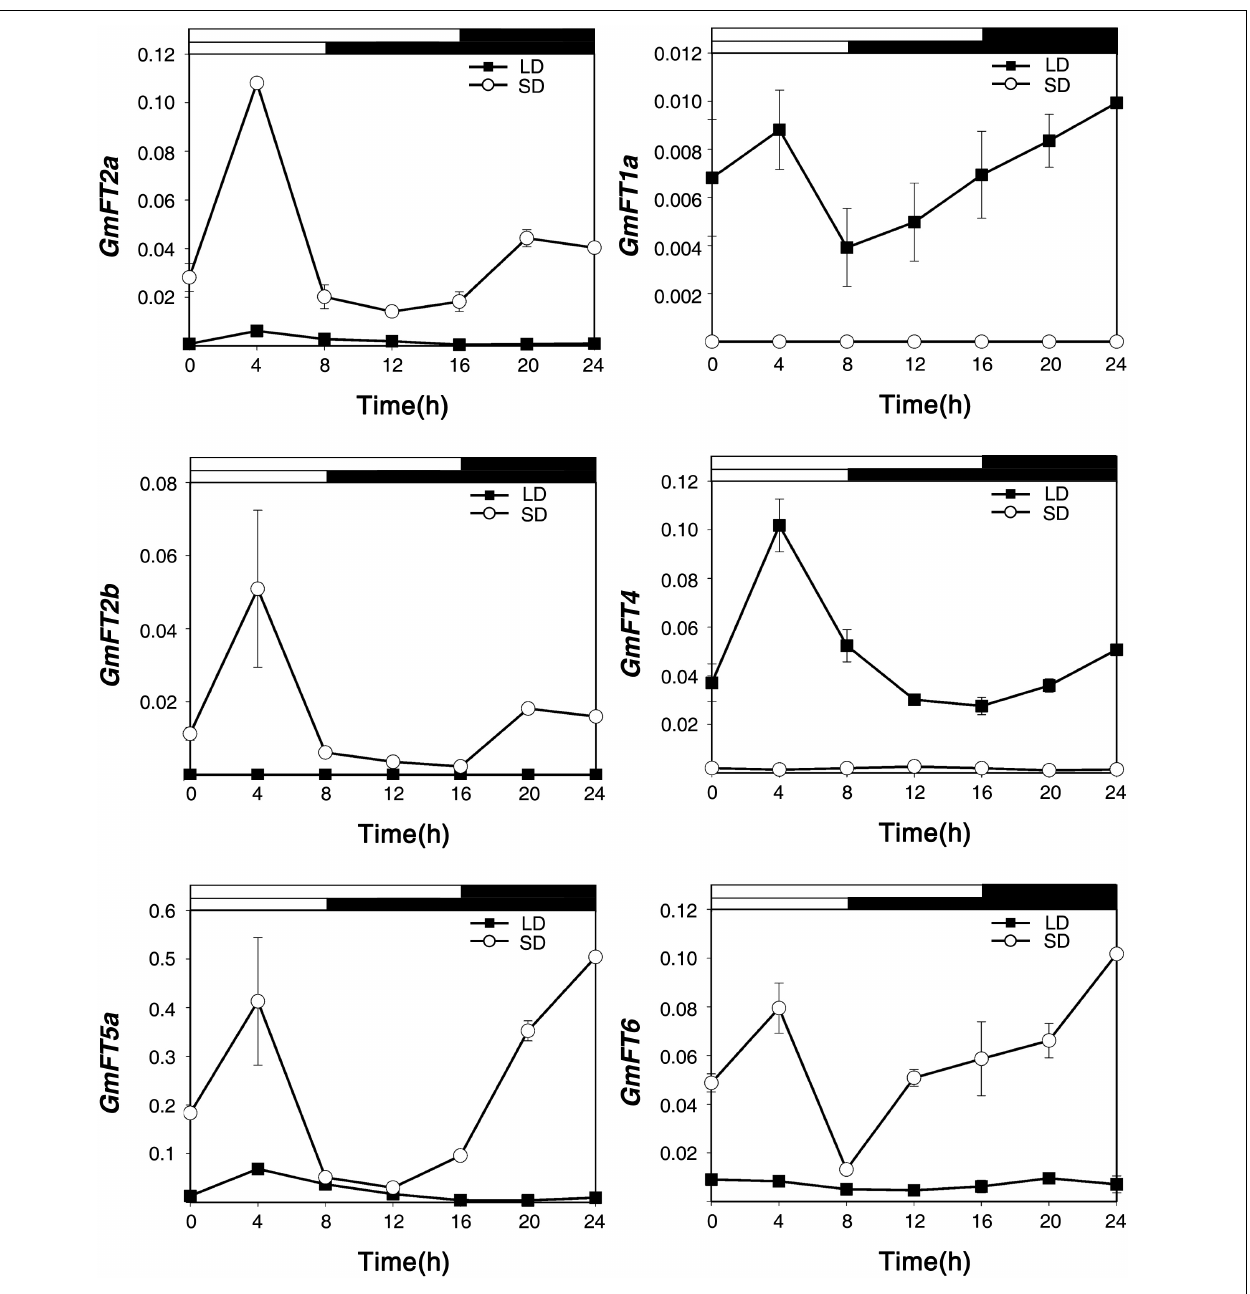
FIGURE 4 | Diurnal expression of GmFT genes under LD and SD conditions. Total RNAs were extracted every 4 h from the first trifoliate leaves of 20-day old LD- and SD-grown plants, respectively. Relative mRNA levels of GmFT genes were analyzed by quantitative real-time PCR with three independent biological replicates and normalized to GmPBB2 mRNA. White and dark bars indicate light and dark phases, respectively. Data are shown as means ± standard